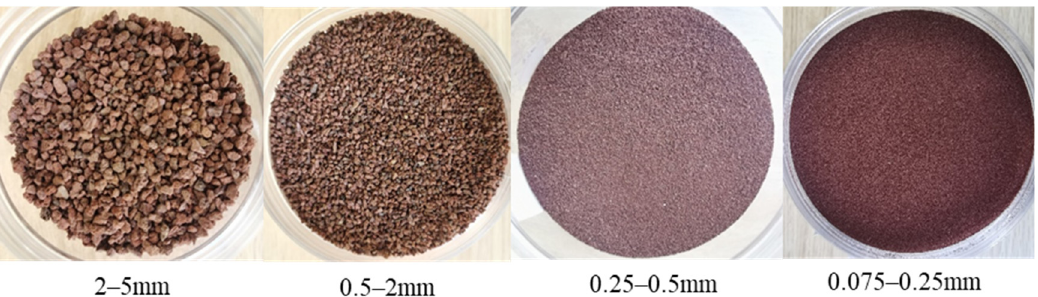
Figure 3. Determination sieving test time and corresponding particle size distribution curve: ( a ) sieving test time; ( b ) particle size distribution curve.